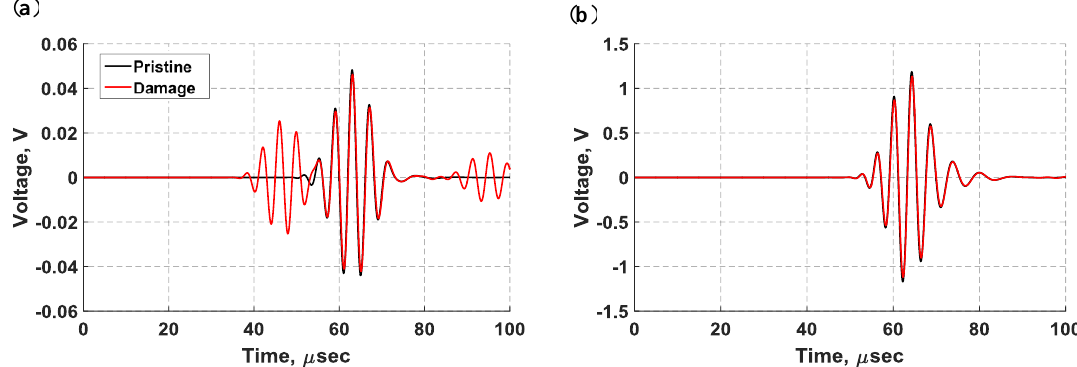
Figure 17. Sensor signals from the pristine state (black) and damaged state (red) at 250 kHz for: ( a ) d31 PZT sensor mounted on the surface of the laminate structure; ( b ) d35 PZT sensor embedded within the bondline.